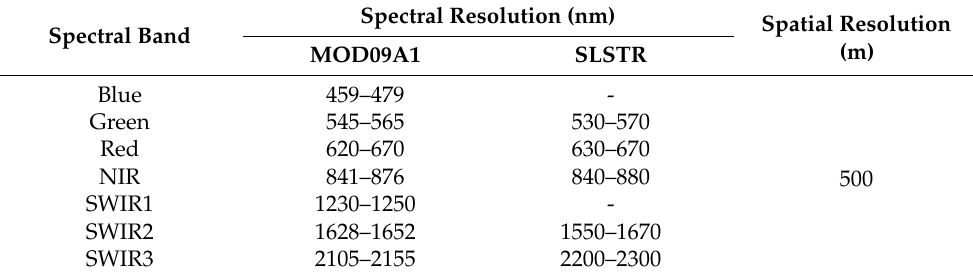
Table 1. Characteristics of the images obtained by the MODIS (MOD09A1) and SLSTR (RBT-1B) sensors used in this study. Source: adapted from Vermote [38] and Sentinel-3 [37] (https://sentinel.